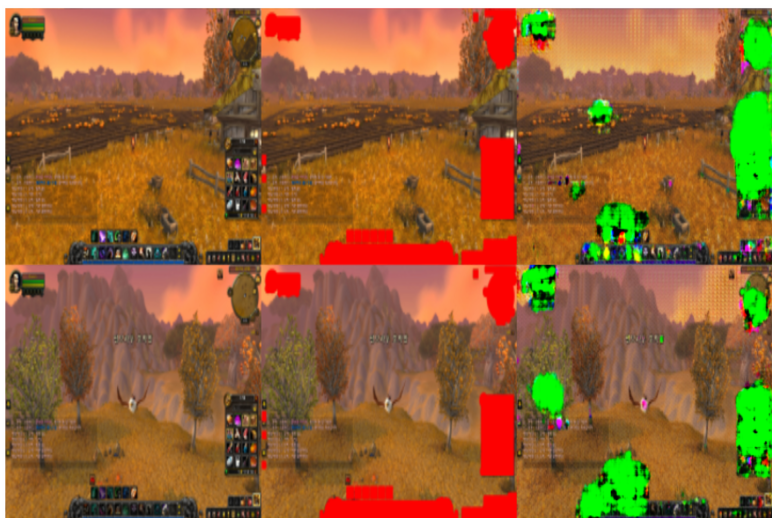
Figure 14. Result of applying the network trained with Black Desert to WOW image. (Left: Original image, Middle: Ground truth, Right: Segmented